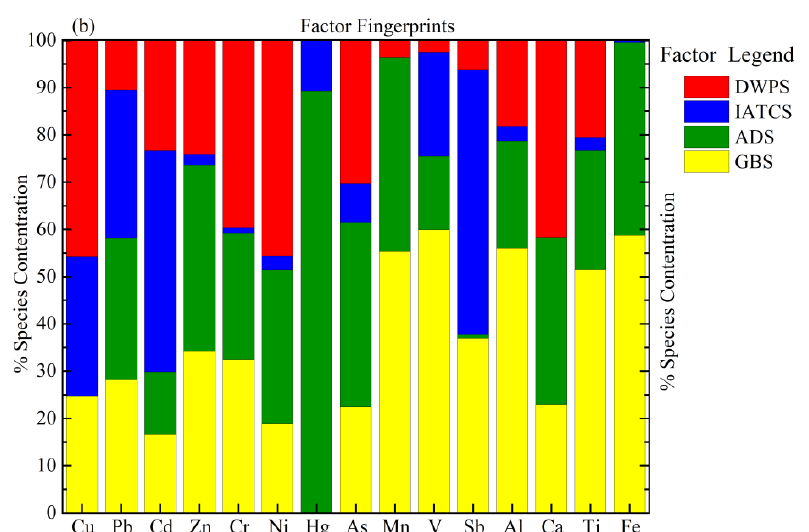
Figure 5. Factor profiles exhibiting the metal concentration percentages acquired from the PMF model via various origins in JDY ( a ) and HH ( b ) peatlands. TS represents traffic sources; DWPS: domestic waste pollution source; MIAS: mining industry and agricultural activities; GBS: geological background source; IATCS: industrial-agricultural-transportation complex source; ADS: atmospheric deposition source.